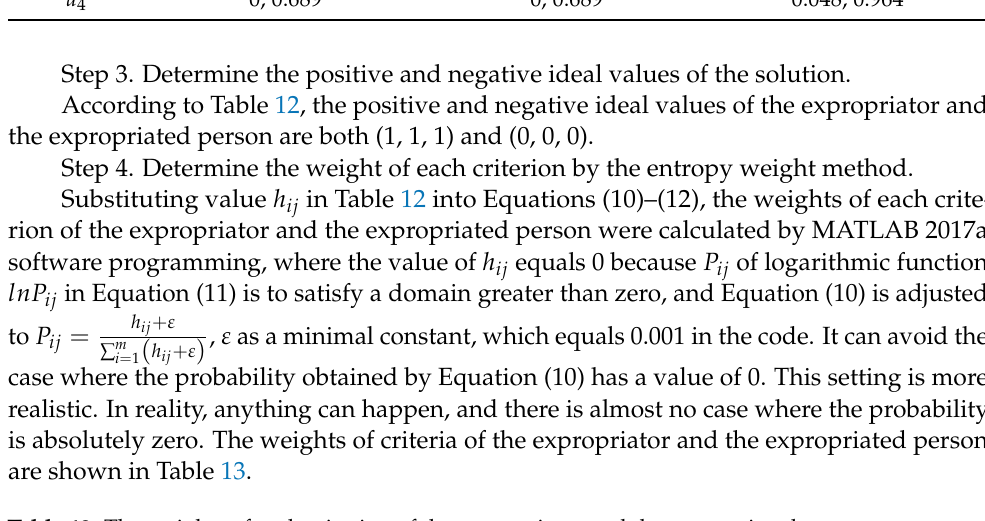
Table 13. The weights of each criterion of the expropriator and the expropriated person.